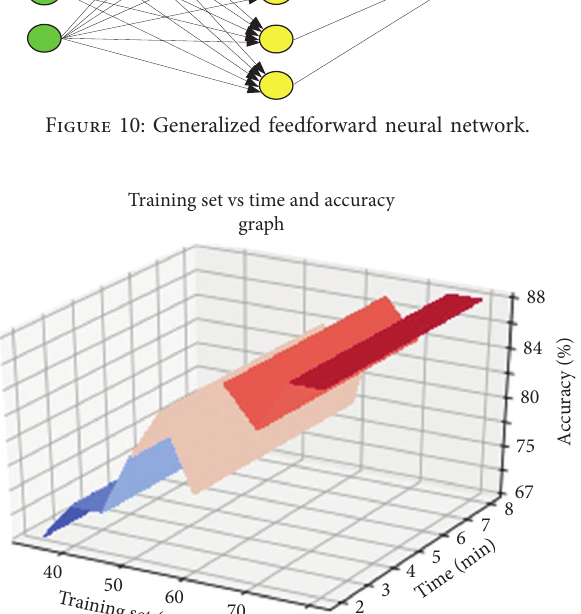
Figure 11: Recognition results of feedforward neural network.